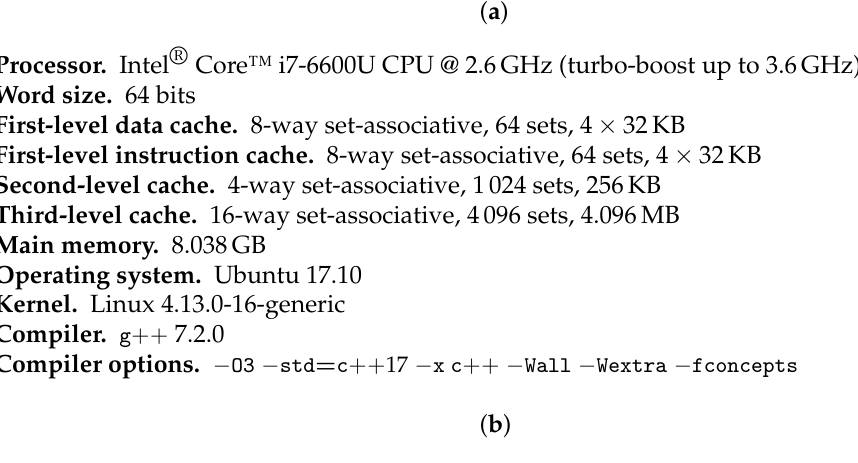
Table 1. Hardware and software in use: ( a ) Linux computer, ( b ) Windows computer. ( a